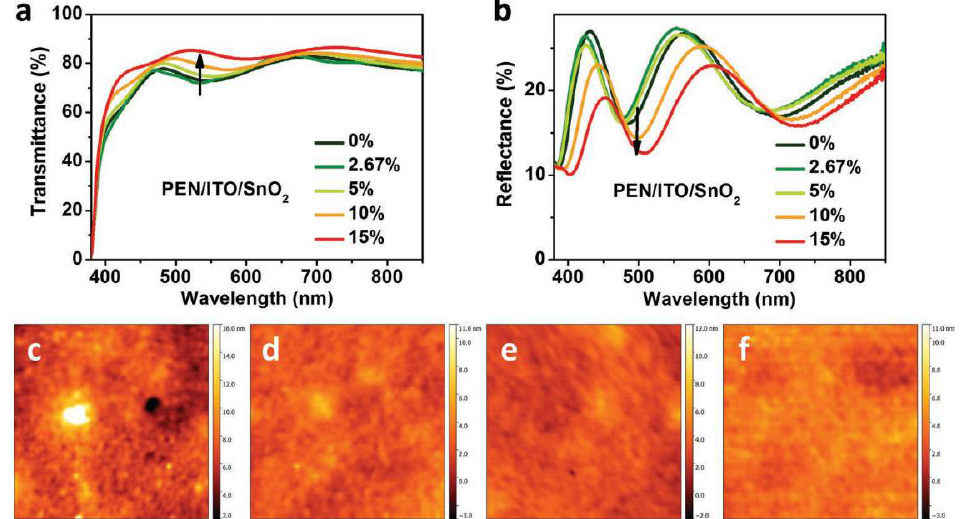
Figure 5. The influence of SnO 2 concentration on surface performance, transmission and reflection of solar cells. ( a , b ) Transmission spectra and reflectance spectra of the structure of PEN/ITO/SnO 2 with difference SnO 2 concentration; AFM pictures of SnO 2 film with different SnO 2 concentration: ( c ) 2.67%, ( d ) 5%, ( e ) 10%, ( f ) 15% [44].